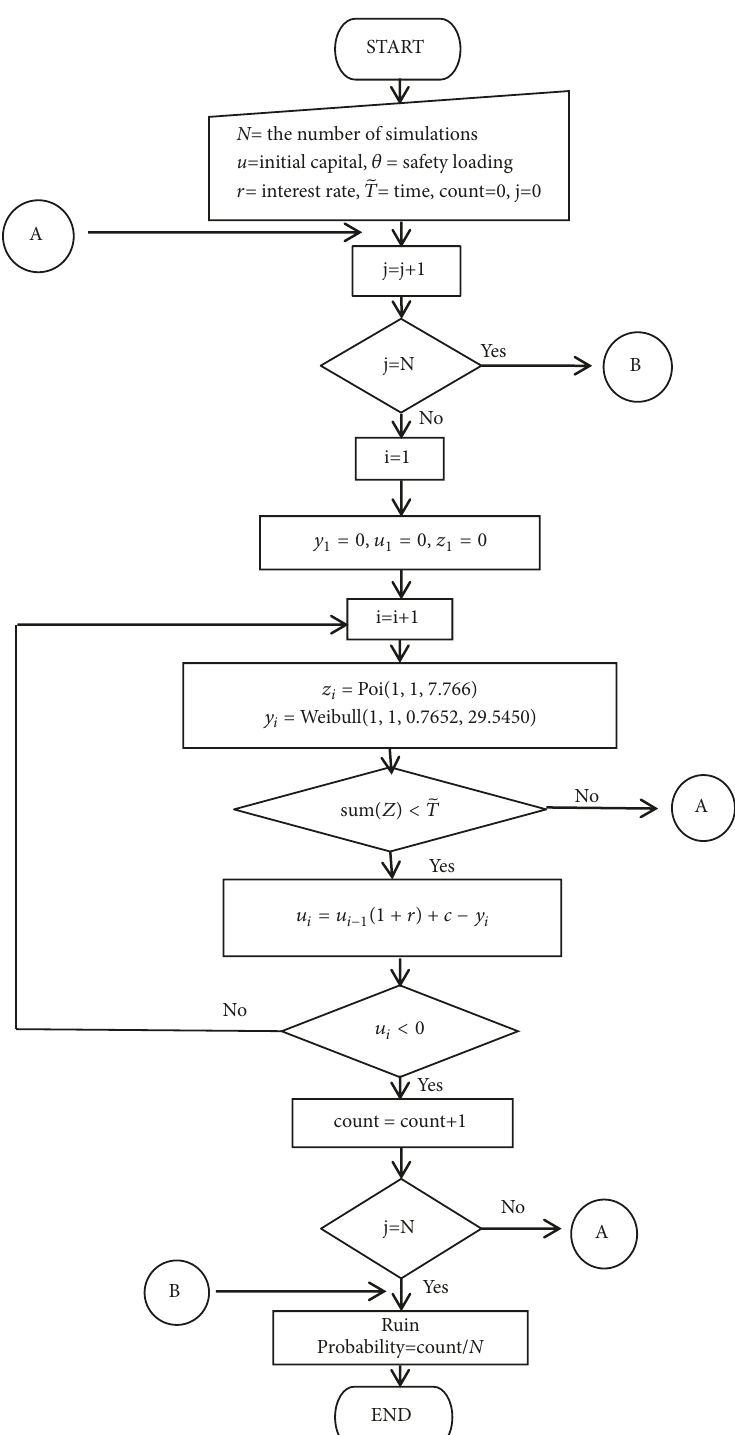
Figure 2: The flow chart of a simulation of the ruin